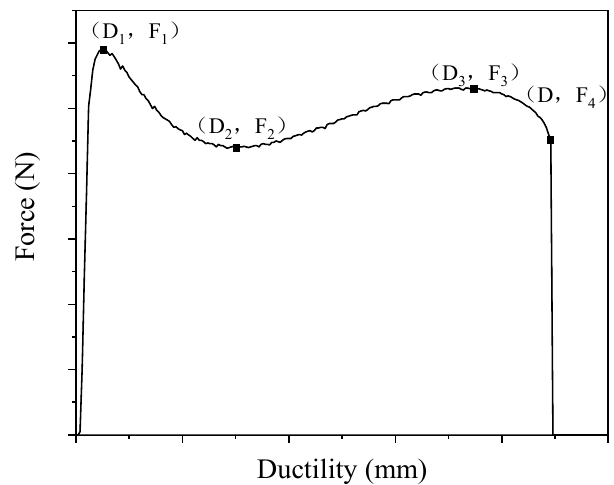
Figure 5. Typical rubberized bitumen force ductility curves.